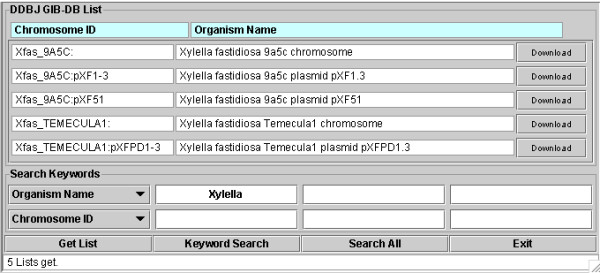
Remote DB screen. The list can be updated by clicking Get List, and users can obtain an FF by clicking the Download button beside the organism name in the list.